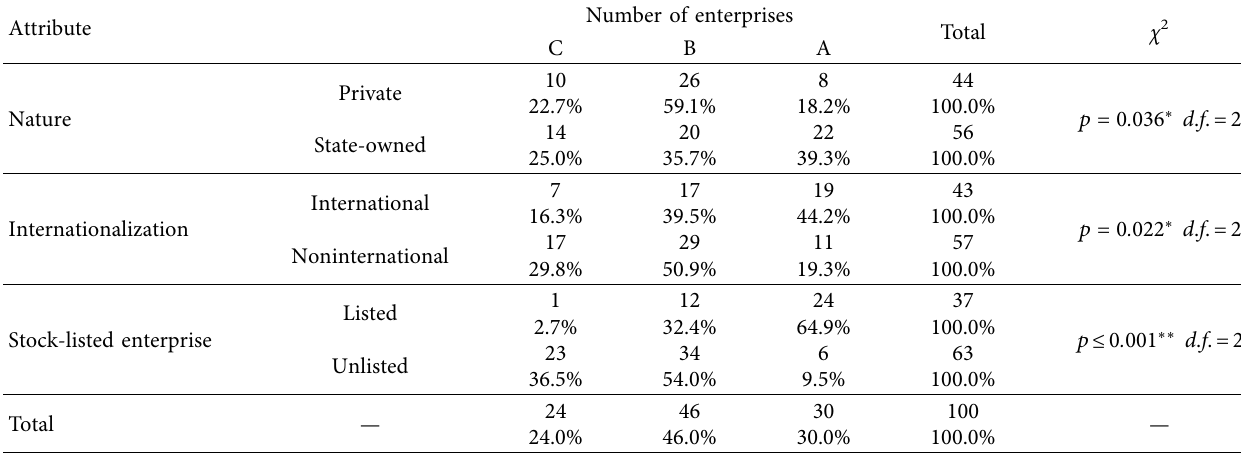
Table 3: Relationships between CSR information disclosure category and corporate